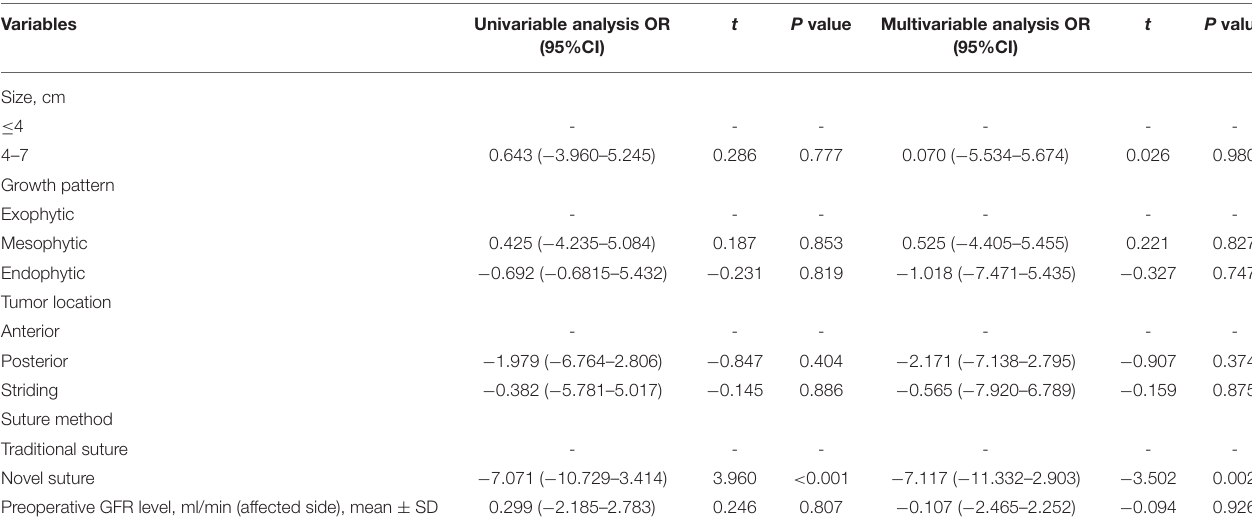
TABLE 5 | Univariable and multivariable associations with clamping